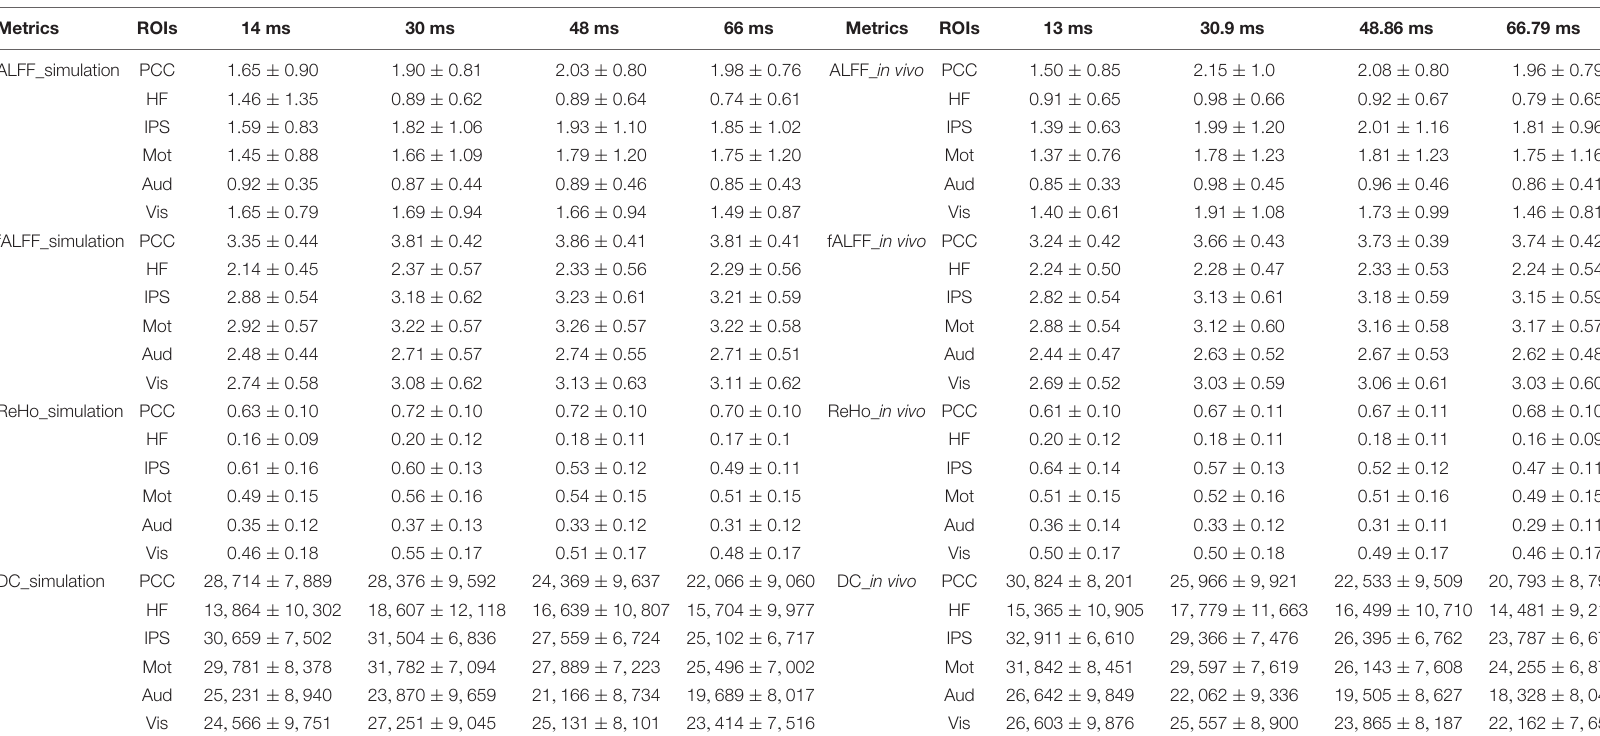
TABLE 1 | The mean and standard deviation of the group averaged simulated and in vivo ALFF, fALFF, ReHo, and DC of six ROIs across different TEs under eyes closed condition.